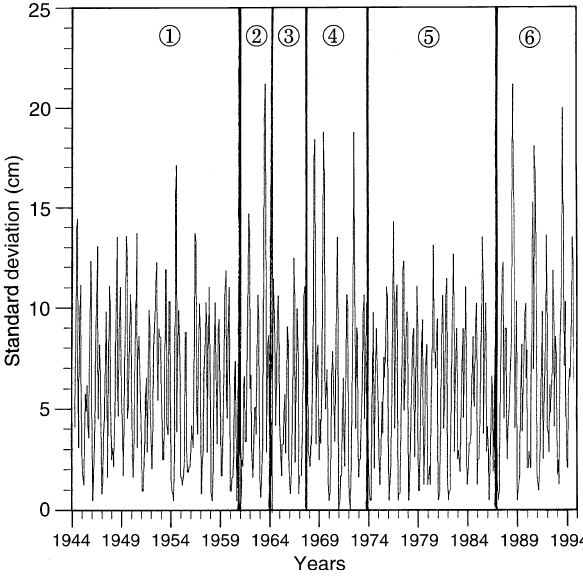
Fig. 12. Three monthly moving averages of the standard deviation